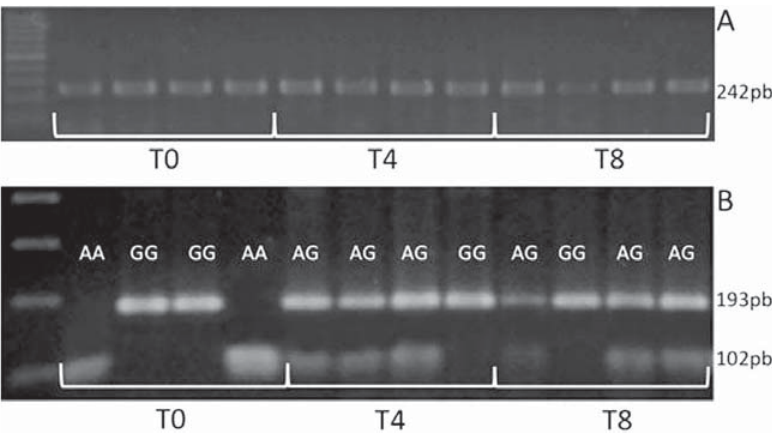
Figure 2- Epidermal growth factor (EGF) polymorphism (rs 4444903) genotyped by polymerase chain reaction - restriction fragment length polymorphism (PCR-RFLP) using DNA extracted from different incubation times (T0, T4 and T8); A) PCR amplicons and B) digestion with Alu I